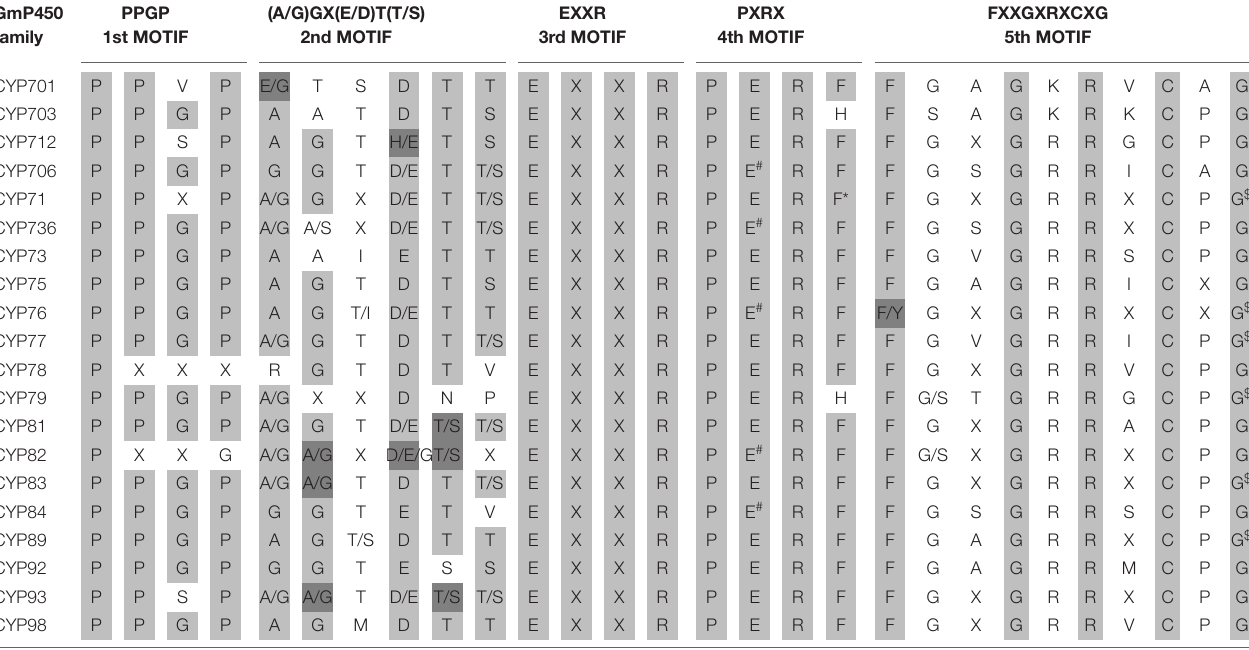
TABLE 1 | Conserved motifs present in A-type GmP450